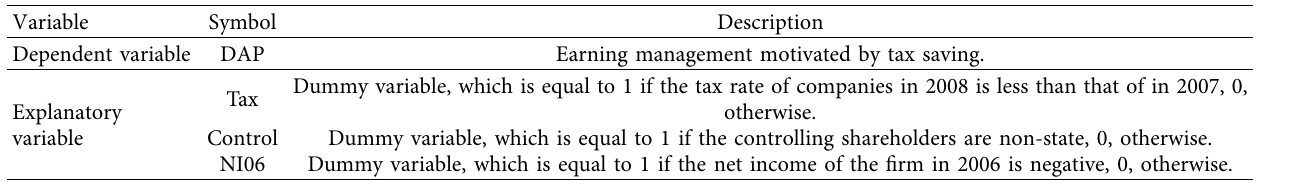
Table 2: Definition of